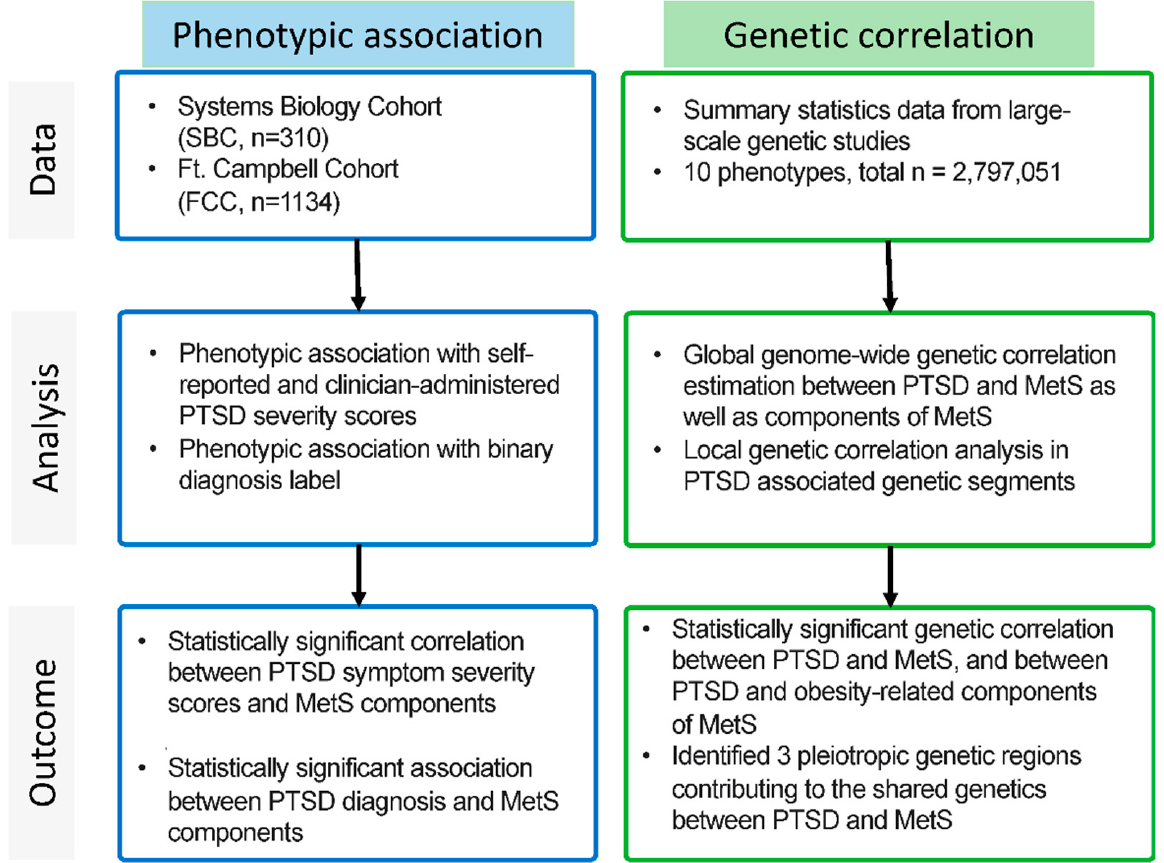
Figure 5. Workflow of the study.